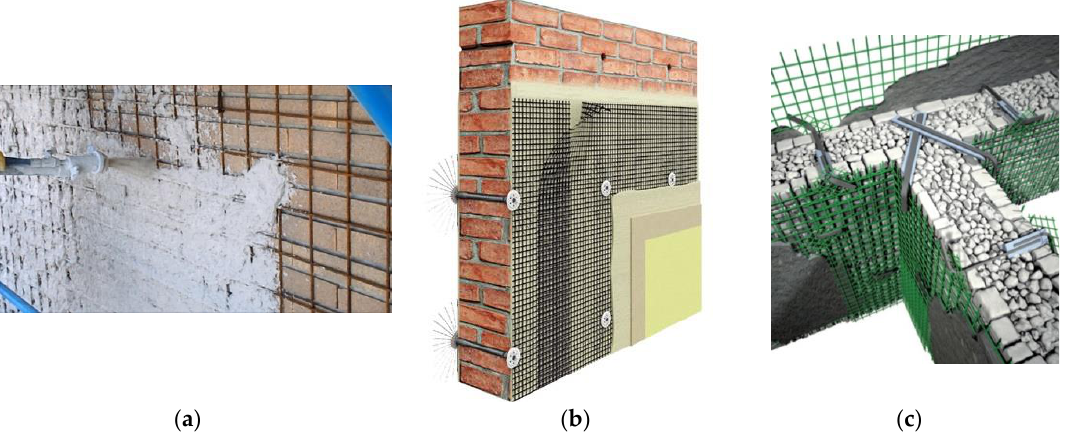
Figure 3. Traditional and innovative methods for the in-plane reinforcement of load-bearing walls: ( a ) steel-rebar-reinforced concrete jacket, ( b ) Fiber Reinforced Matrix (FRM)—flexible non-impregnated fiber meshes, and ( c ) FRM—impregnated (rigid) glass-fiber-reinforced polymer (GFRP) mesh embedded into a cementitious / lime matrix